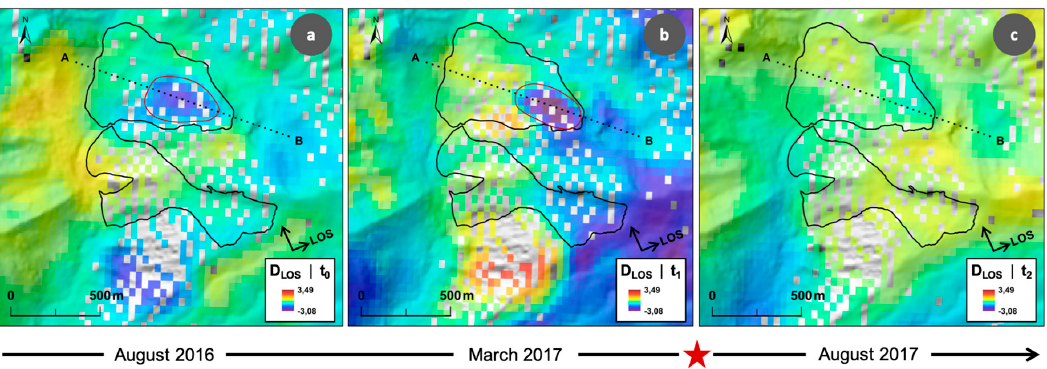
Figure 8. D LOS (in cm) observed for the Koytash and Tektonik landslides in Maily ‐ Say ( a ) D LOS between 2 August and 14 August 2016—t 0 ; ( b ) D LOS between 18 March and 30 March 2017—t 1 ; ( c ) D LOS between 9 August and 21 August 2017—t 2 . The negative D LOS (in blue) and positive (in red) indicate respectively the points moving away and approaching the radar sensor. The interferograms are displayed in transparency on the TanDEM-X hillshade. On these interferograms, the thin black line presents the boundaries of the landslide and the dotted line corresponds to the A-B profile for which the unwrapped phase values were extracted. The deformation fields within the landslides are outlined in dark red. The red star represents the reactivation in April 2017.